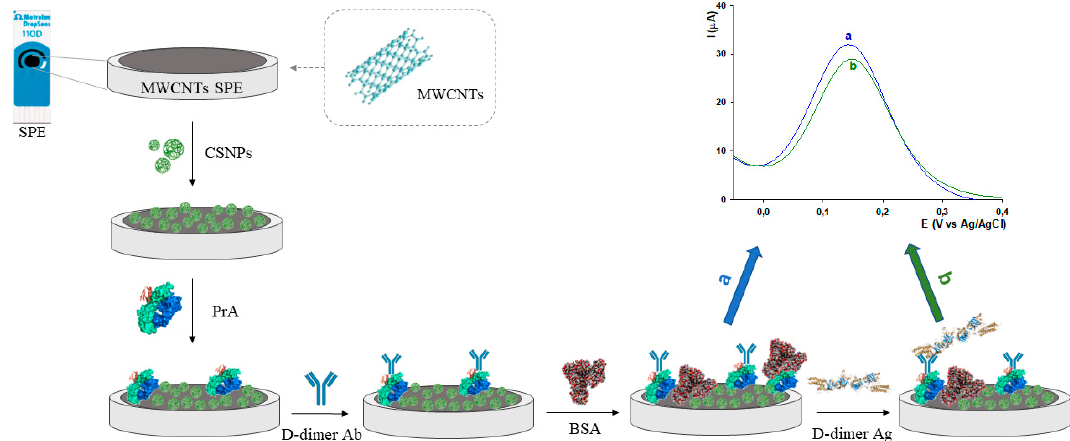
Scheme 1. Schematic representation of the D-dimer electrochemical platform fabrication steps and immunosensor sensing